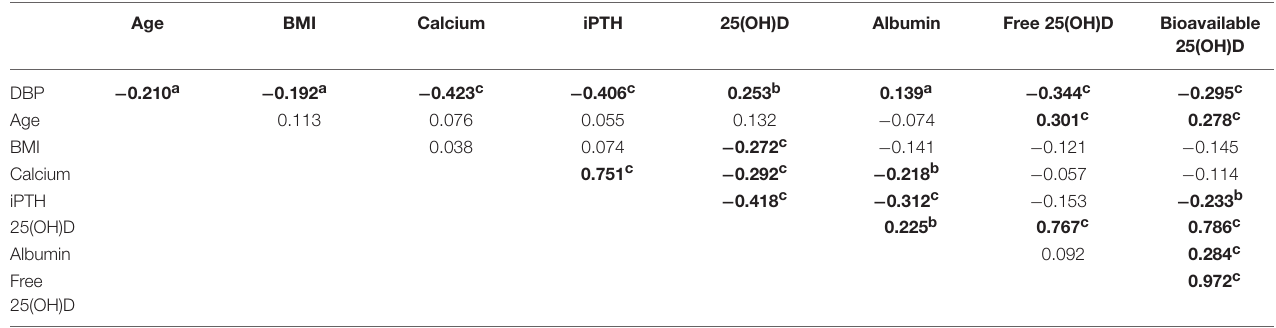
TABLE 2 | Spearman correlation coefficients between DBP and other variables ( n =